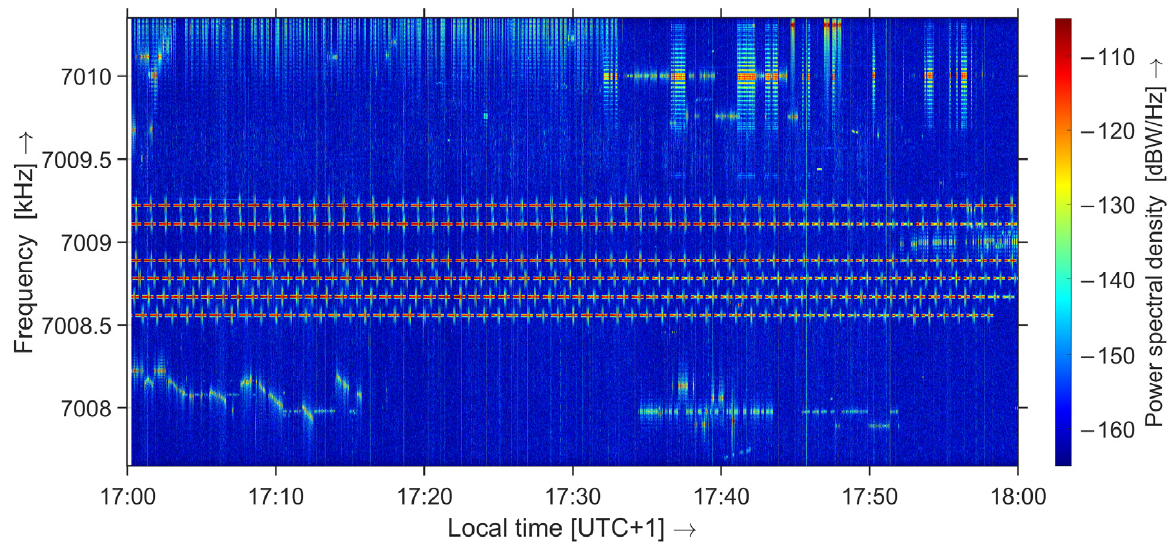
Figure 6. Spectrogram of a 1-h fragment of the unprocessed measurements, as an